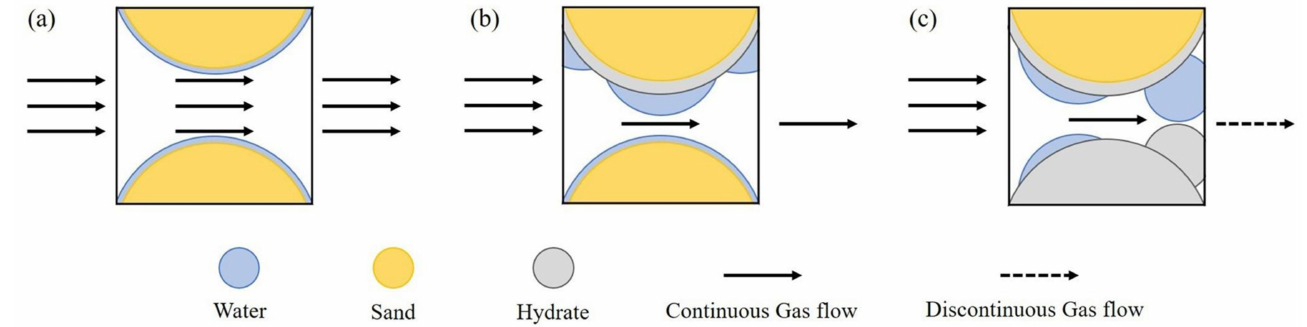
Figure 42. Schematic diagrams of the coupled influence mechanism of hydrate pore habits and wettability evolution on flow behavior in hydrate-bearing mix system reprinted from [69] with permission from Elsevier. ( a ) Initial stage; ( b ) medium S h condition; ( c ) high S h